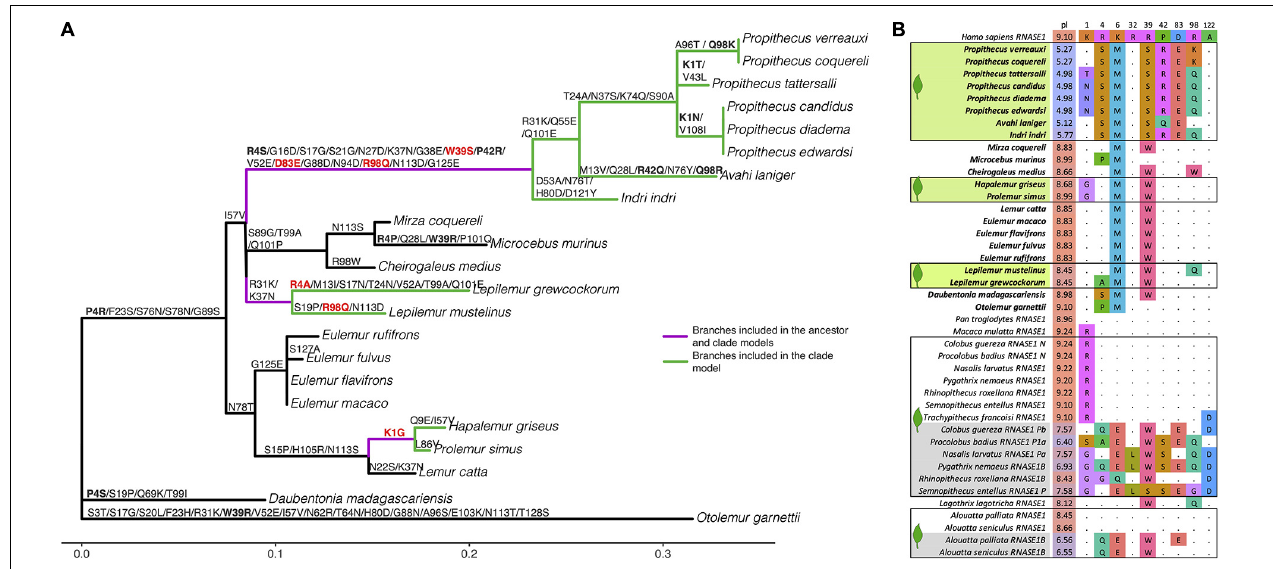
FIGURE 2 | RNase1 substitutions. (A) unrooted phylogenetic tree used for analyses with branches scaled to the number of substitutions per codon. Nonsynonymous substitutions mapped to tree from ancestral sequences reconstructed using codeml. Bolded substitutions occur at sites predicted to impact enzymatic activity that also show substitutions in duplicated RNase1 sequences of colobine monkeys. Substitutions in red involve changes to the same amino acid as in duplicated colobine sequences. The purple branches were the foreground branches in the ancestor positive selection branch model (H1) and branches colored both purple and green were foreground branches in the clade positive selection branch model (H2) and positive selection branch-sites model. (B) Alignment of primate RNase1 sequences at sites predicted/known to influence enzymatic activity. Bolded taxon names are taxa included in the present study, taxon names highlighted in green are folivorous lemurs included in the present study, and taxon names highlighted in gray are the duplicated sequences of colobines and howler monkeys. All folivorous species are outlined and denoted with a leaf icon. pI = isoelectric point at pH = 7. Primate sequences in the alignment not in the present study are from the UCSC 30-way multi-Z alignment and (Zhang et al., 2002; Zhou et al., 2014; Janiak et al.,